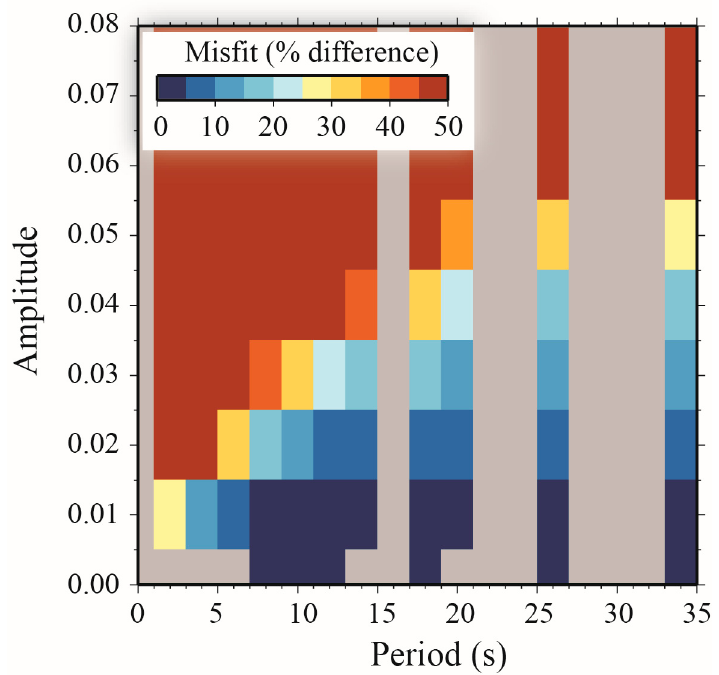
Figure 12. Average percent difference between noisy and non-noisy synthetic seismograms for 2.5-D ULVZ models with length ( l ) = 3°. Results are shown for a synthetic seismogram computed at an epicentral distance of 120°.